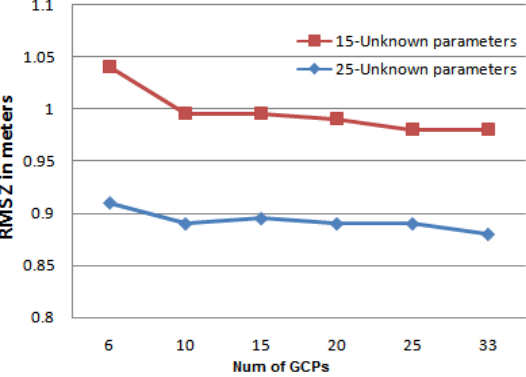
Figure 6. RMS in Z-coordinate of ICPs as function of GCP